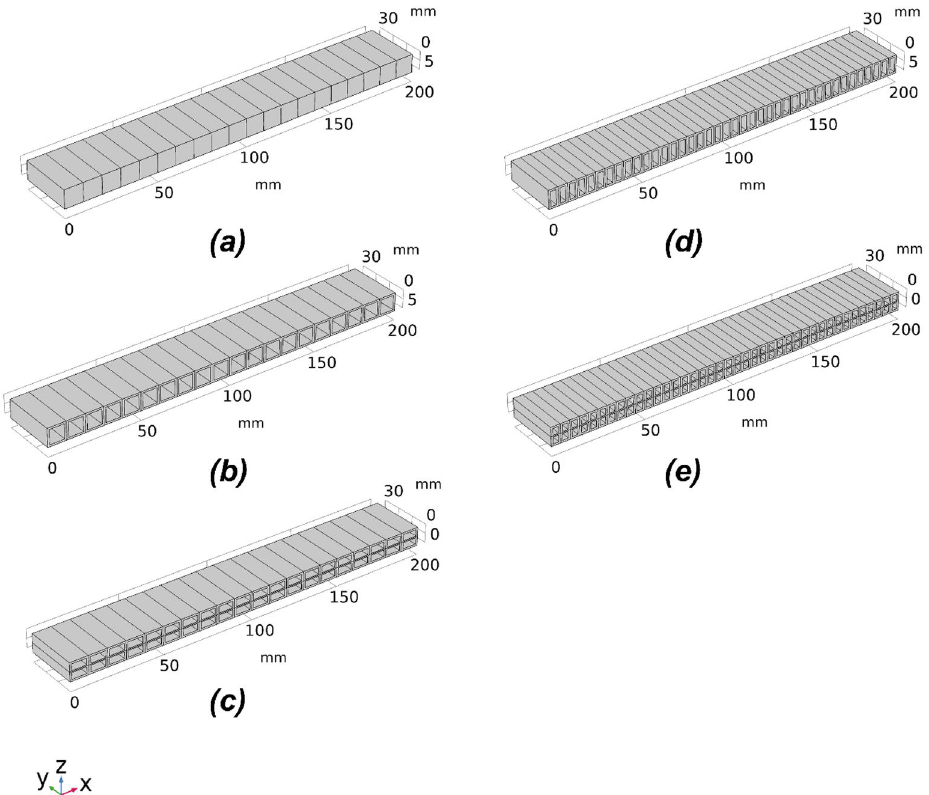
Figure 5. The low bound and high bound structural settings for the voxels for optimising the deflection behaviour of the beam. ( a ) the low bound structure for all voxelisation settings; ( b ) high bound structure for 20 voxels model with single symmetric or asymmetric voids; ( c ) high bound structure for 20 voxels model with double voids; ( d ) high bound structure for 40 voxels model with single symmetric or asymmetric voids; ( e ) high bound structure for the 40 voxels model with double voids. (Images are created by the authors using Solidworks Educational Version 30.3.1.2